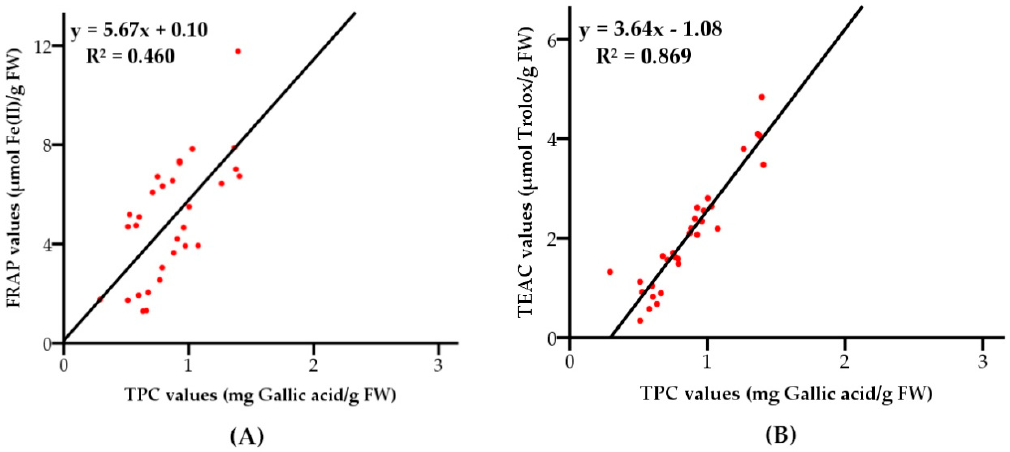
Figure 8. Correlations between FRAP values ( A ), TEAC values ( B ) and total phenolic contents of the 30 grape varieties.